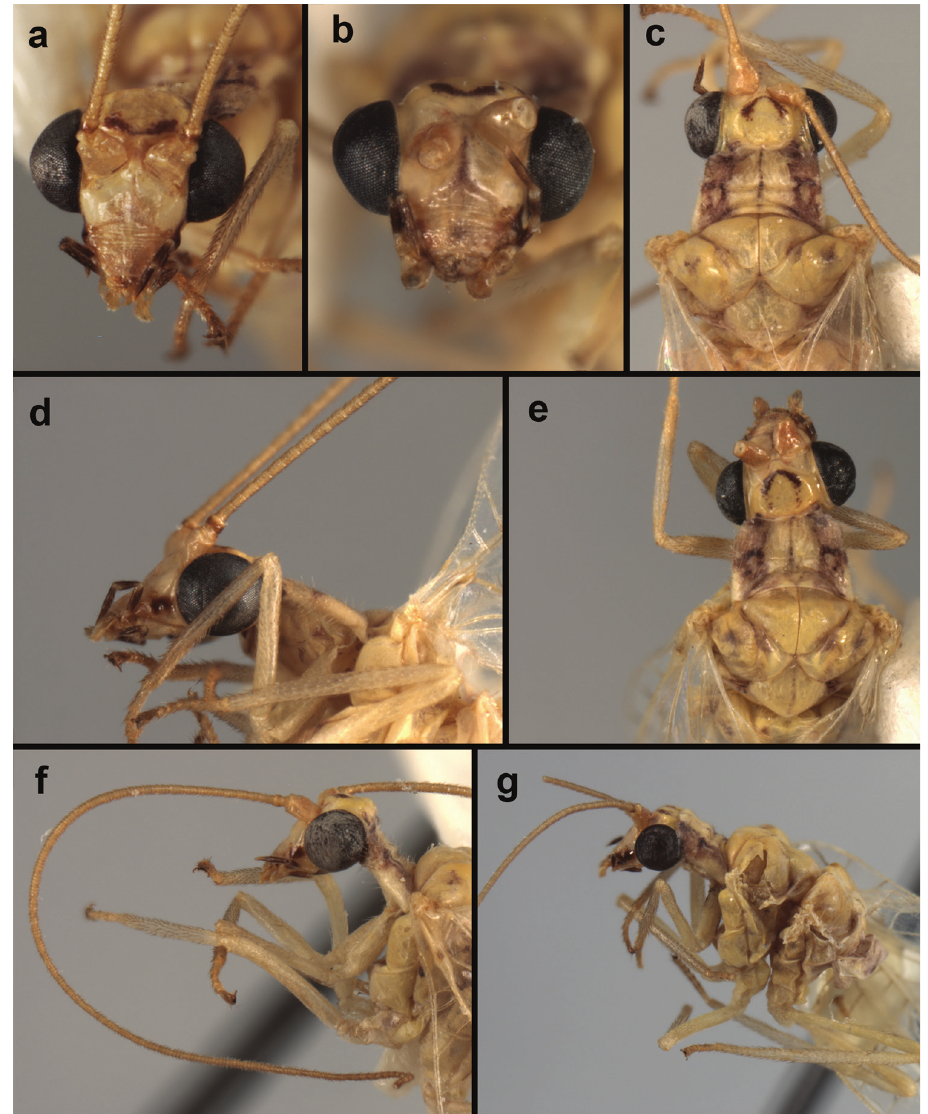
Figure 71. Ungla species near pallescens Penny: External features, ( a, b ) head, frontal ( c ) head, pro- thorax, dorsal ( d ) head, prothorax, lateral ( e ) head, partial thorax, dorsal ( f ) head, partial thorax, lateral ( g ) head, thorax, lateral (Bolivia, Cochabamba, female, FSCA).